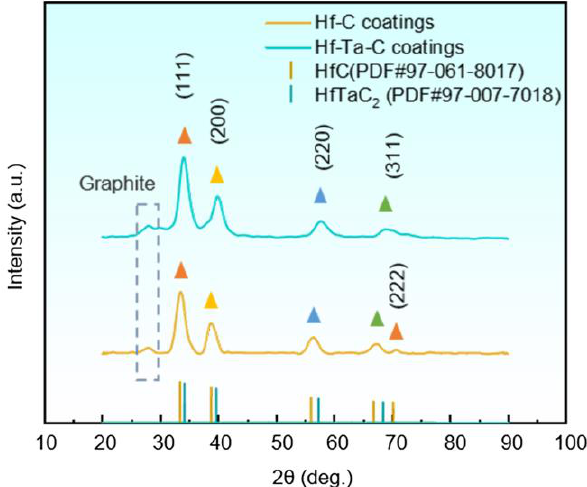
Figure 3. XRD pattern for HfC and HfTaC 2 coatings.